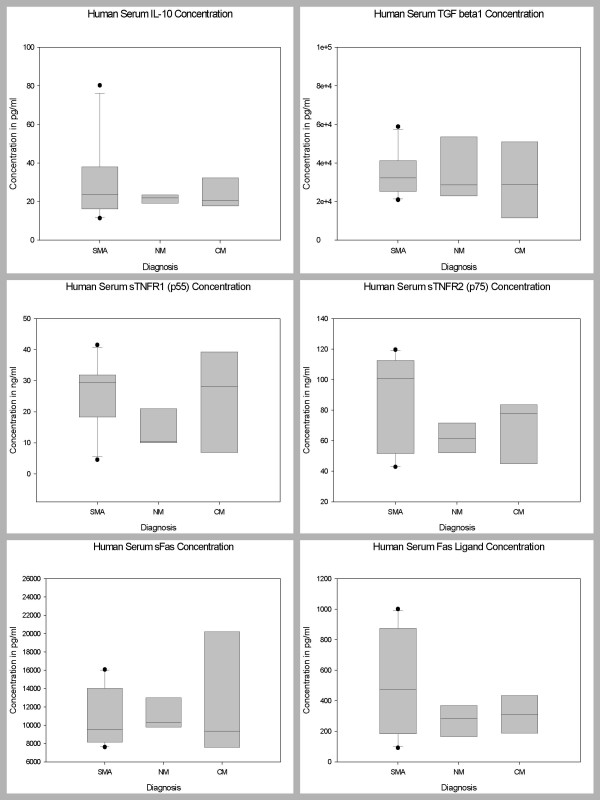
Postmortem serum biomarker levels of IL-10, TGF-βx, sTNF-R1, sTNF-R2, sFas, and Fas-L in children dying with CM, SMA, NM causes. CM, cerebral malaria; SMA, severe malarial anemia; NM, non-malaria. Box plots representing medians with 25th and 75th percentiles, bars for 10th and 90th percentiles, and points for outliers of biomarker concentrations. Only statistically significant P values after Bonferroni adjustment for the other biomarkers are shown.